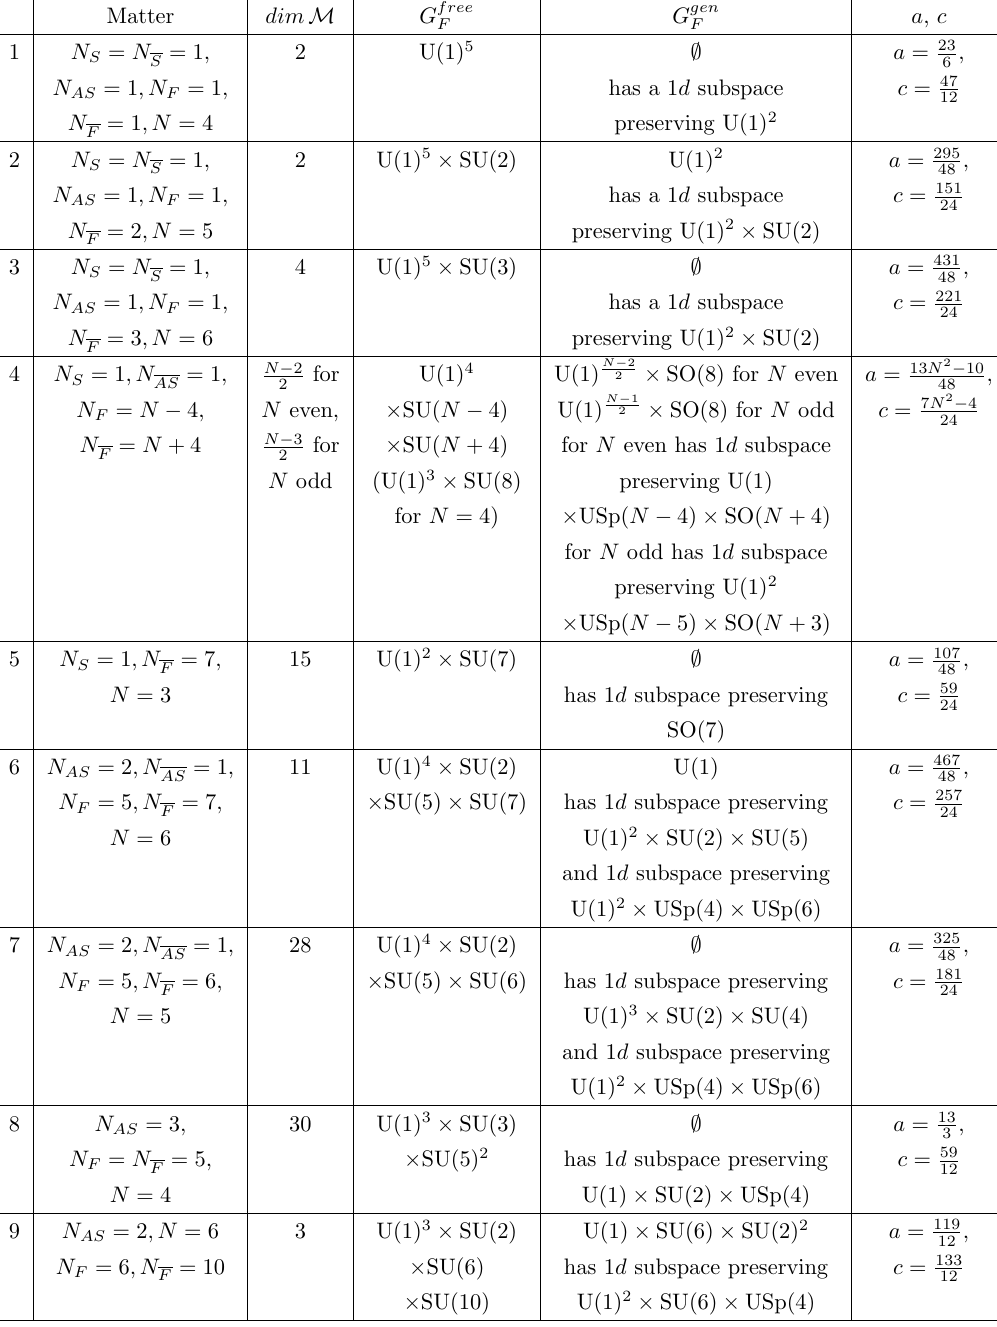
Table 3 . Cases involving an SU( N ) gauge group with one adjoint chiral (cid:12)eld. Note that the adjoint chiral (cid:12)eld is not written in the